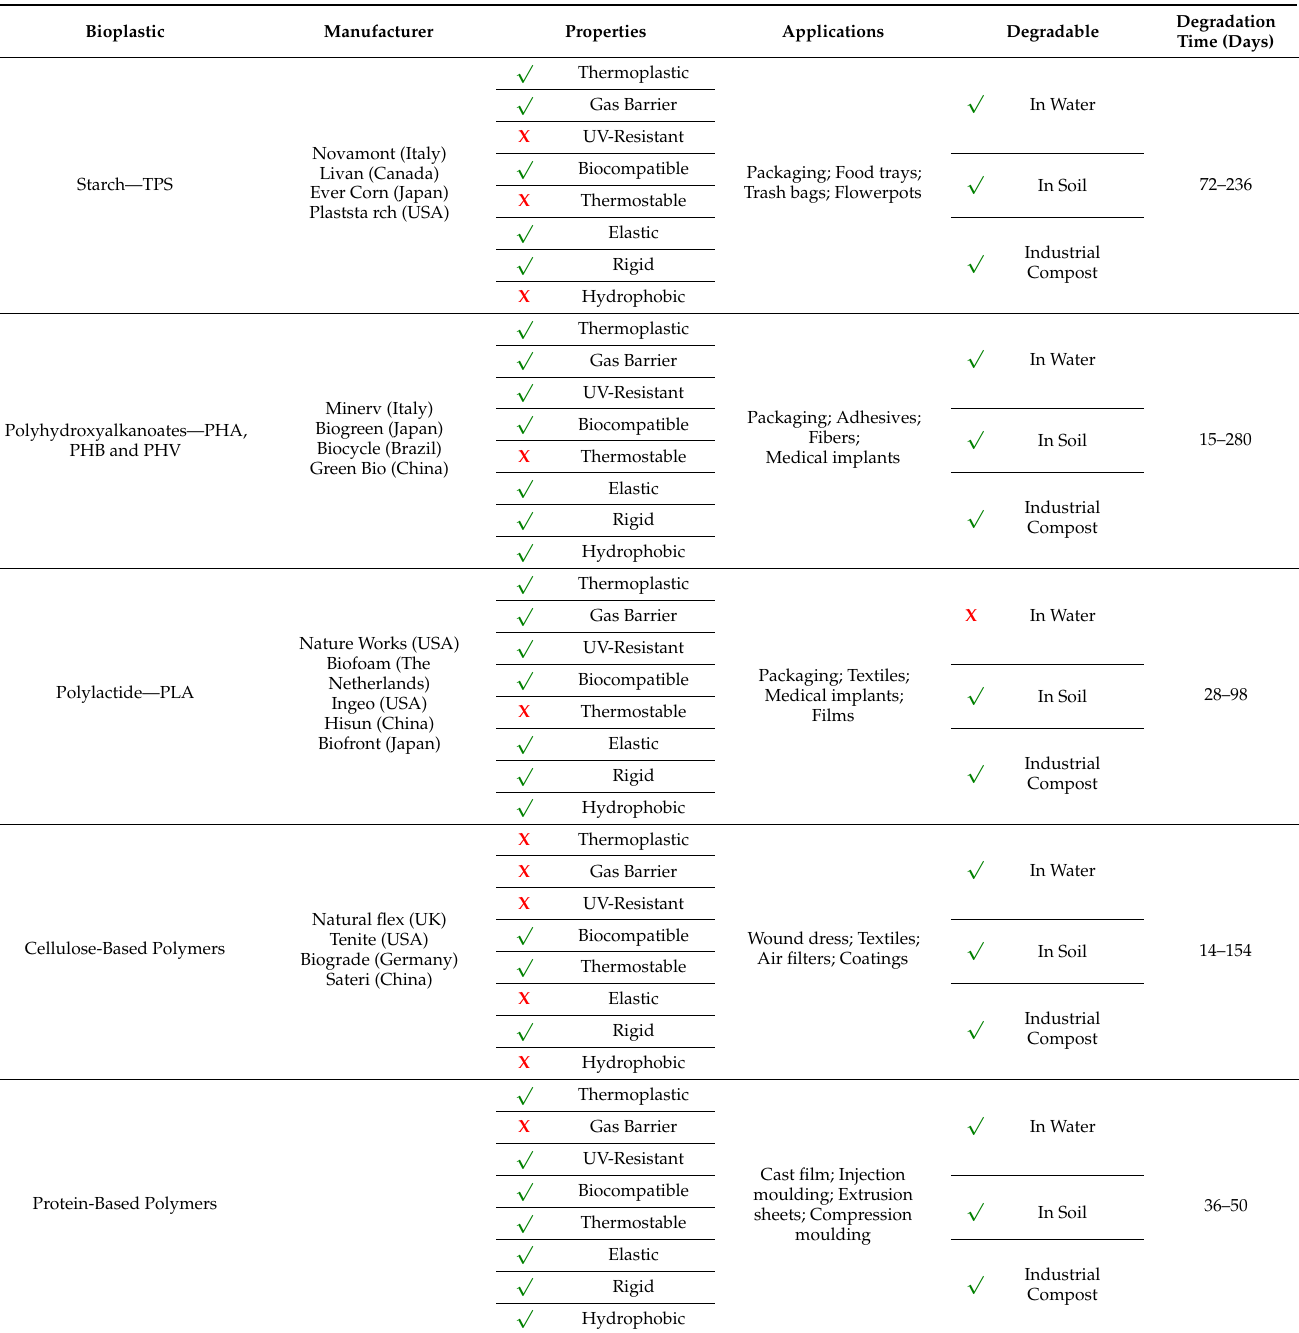
Table 2. Major bioplastic classes, some properties and average degradation time in different environ- √ /X: ments [27–29]. (